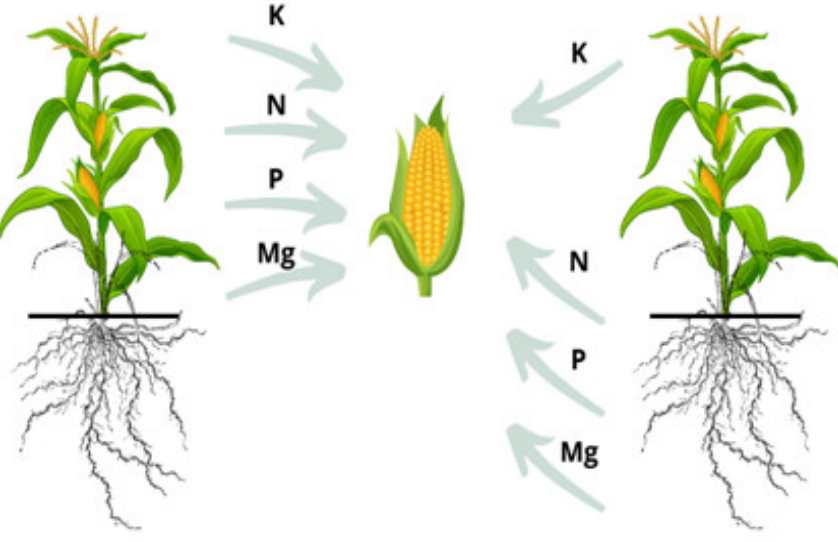
Figure 1. Nutrient remobilization pattern during the grain filling period depending on the type of maize hybrid (on the right, the “stay-green” cultivar, on the left, the traditional cultivar) [13]. Stabilized nitrogen fertilizers contain nitrification or urease inhibitors. The main purpose of their use is to increase the efficiency of plant fertilization with nitrogen (by reducing the number of applications and ensuring a wider range of application dates), as well as improve environmental conditions by reducing the risk of releasing excess nitrogen into the groundwater and air [14]. Nitrification inhibitors reduce the intensity of the microbial transformations of ammonium ions (NH + ) towards nitrate ions (NO − ) and 3 4 free nitrogen (gaseous N 2 and nitrous oxide N 2 O—greenhouse gases) in the soil. A urease inhibitor, on the other hand, is a compound that temporarily slows down the enzymatic conversion of urea to CO 2 and NH 3 due to its inhibitory effect on urease. This is of great importance, especially in alkaline soils, as it reduces nitrogen losses due to ammonia volatilization. A urease inhibitor blocks the conversion of urea to ammonia for one to two weeks. This reduces the risk of losses due to its evaporation, providing a major advantage over non-stabilized urea [2,15]. Data from the literature provide different information on the response of maize to nitrogen application [16,17]. According to some authors, very high doses of nitrogen increased yield [18]. The expected maize response to increasing levels of nitrogen fertilization is referred to as a “creeping reaction”, i.e., even high and very high doses of the component cause small increases in yield or at least do not cause